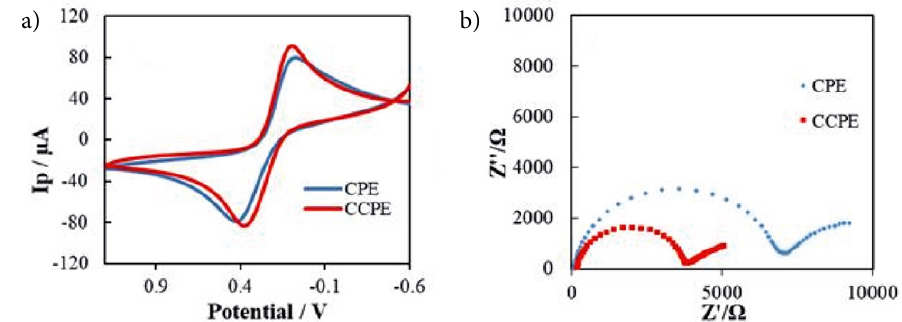
Figure 2. a) CV voltammograms b) Nyquist plots of CPE and CCPE in 5.0 mM Fe(CN) 63– /Fe(CN) 64– in 0.1 M KCl